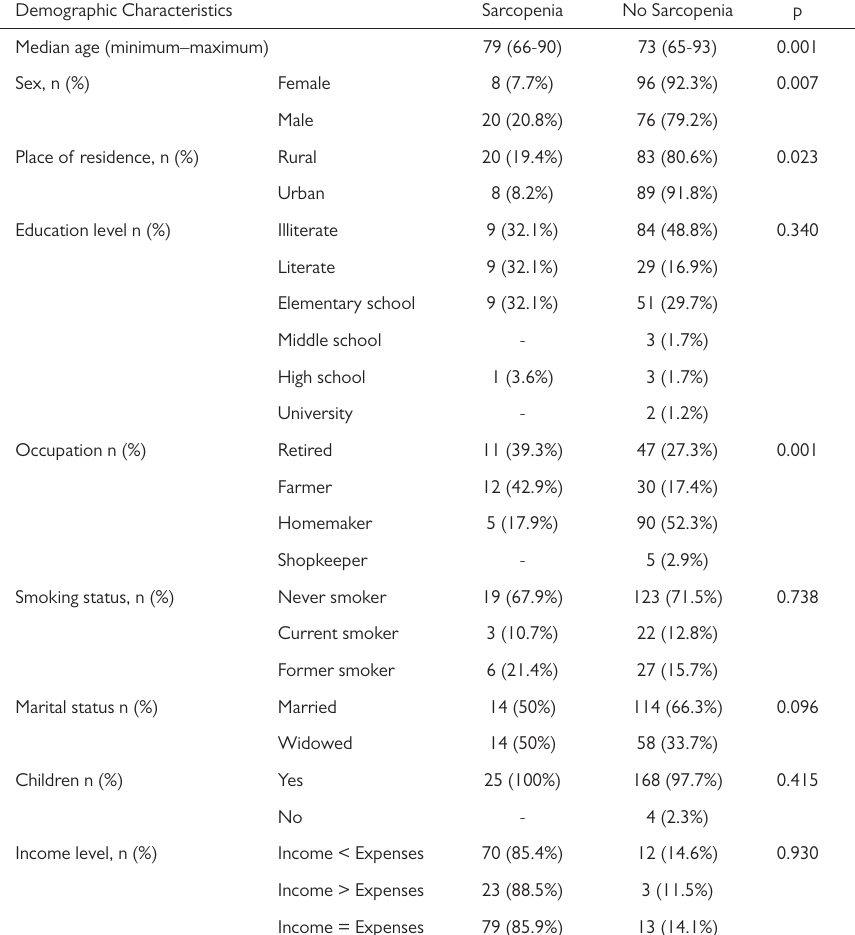
Table 1. Association between sarcopenia and demographic characteristics Demographic